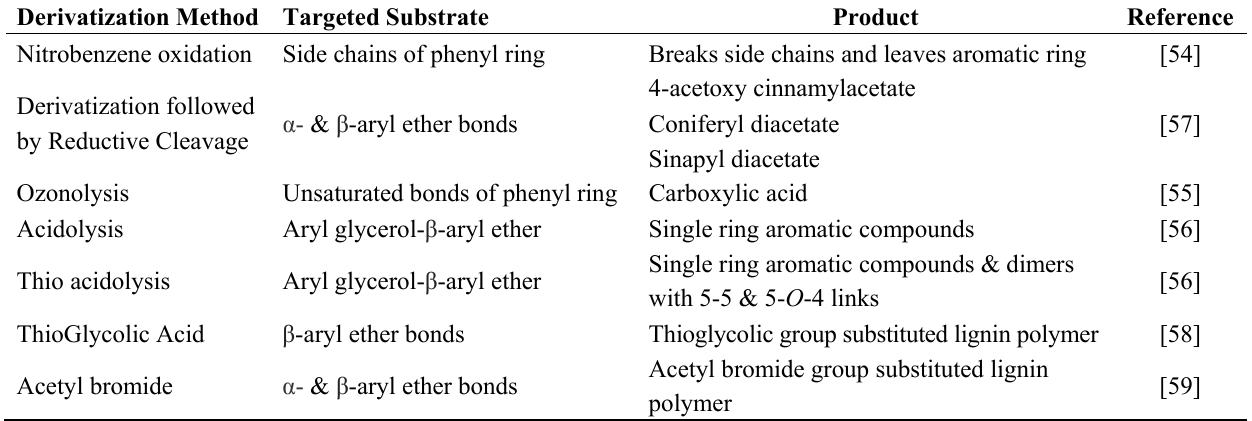
Table 2. Lignin derivatization methods with targeted substrate & resulting